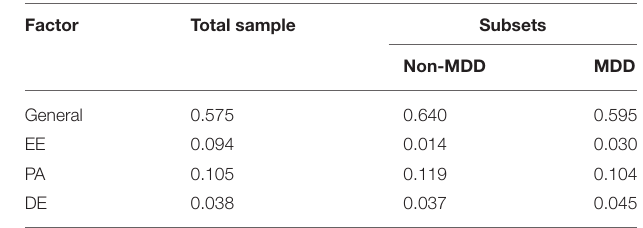
TABLE 4 | Reliability of MBI-HSS (Cronbach’s Alpha): total sample, MDD and non-MDD subsets.